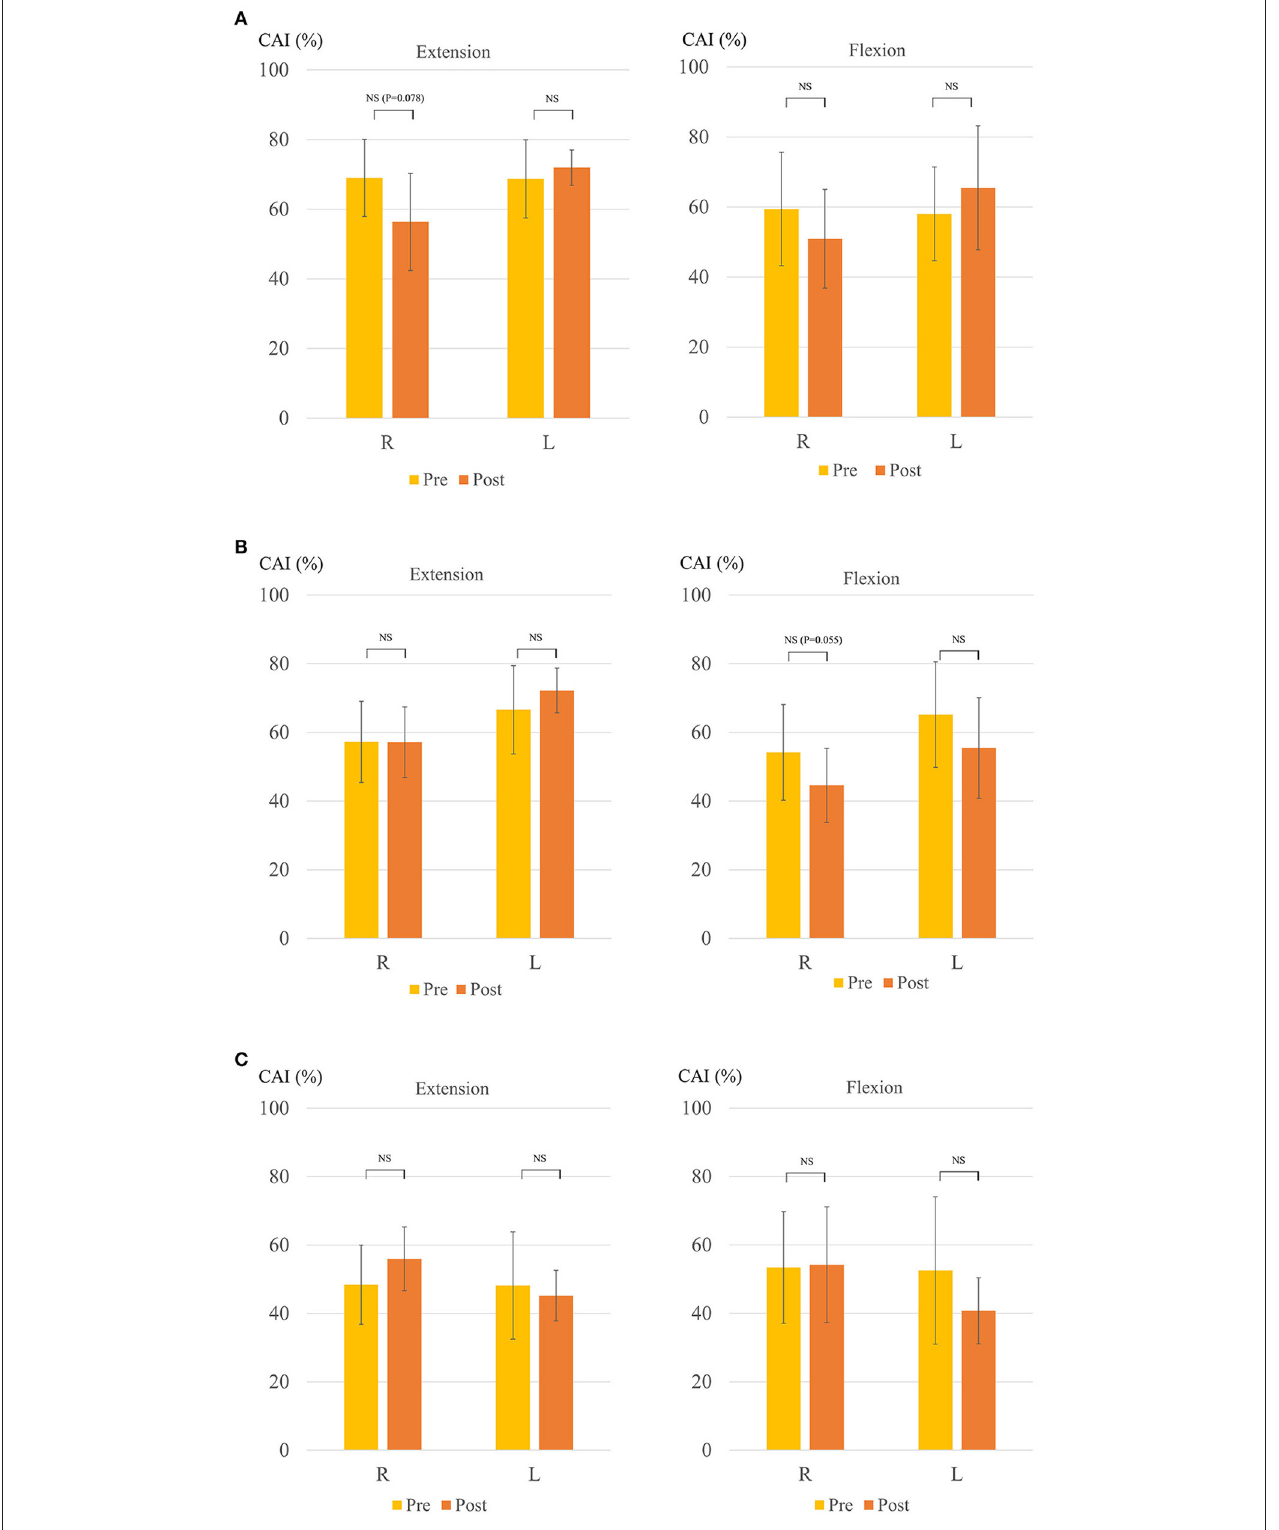
FIGURE 4 | Change in coactivation index (CAI) (A) Right-sided HAL in Case 1. (B) Left-sided HAL in Case 1. (C) Right-sided HAL in Case 2. Y-axis shows CAI (%). The right side shows the extension and the left shows the flexion in each figure.